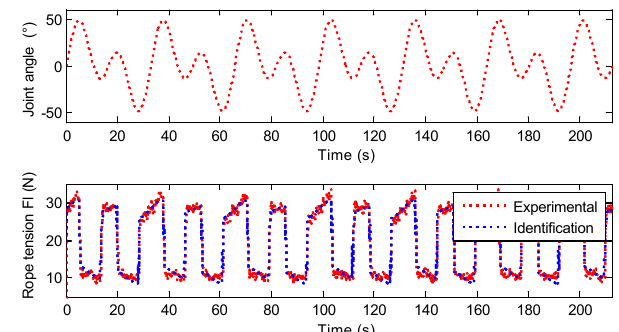
Figure 17. The identification result of the simplified model